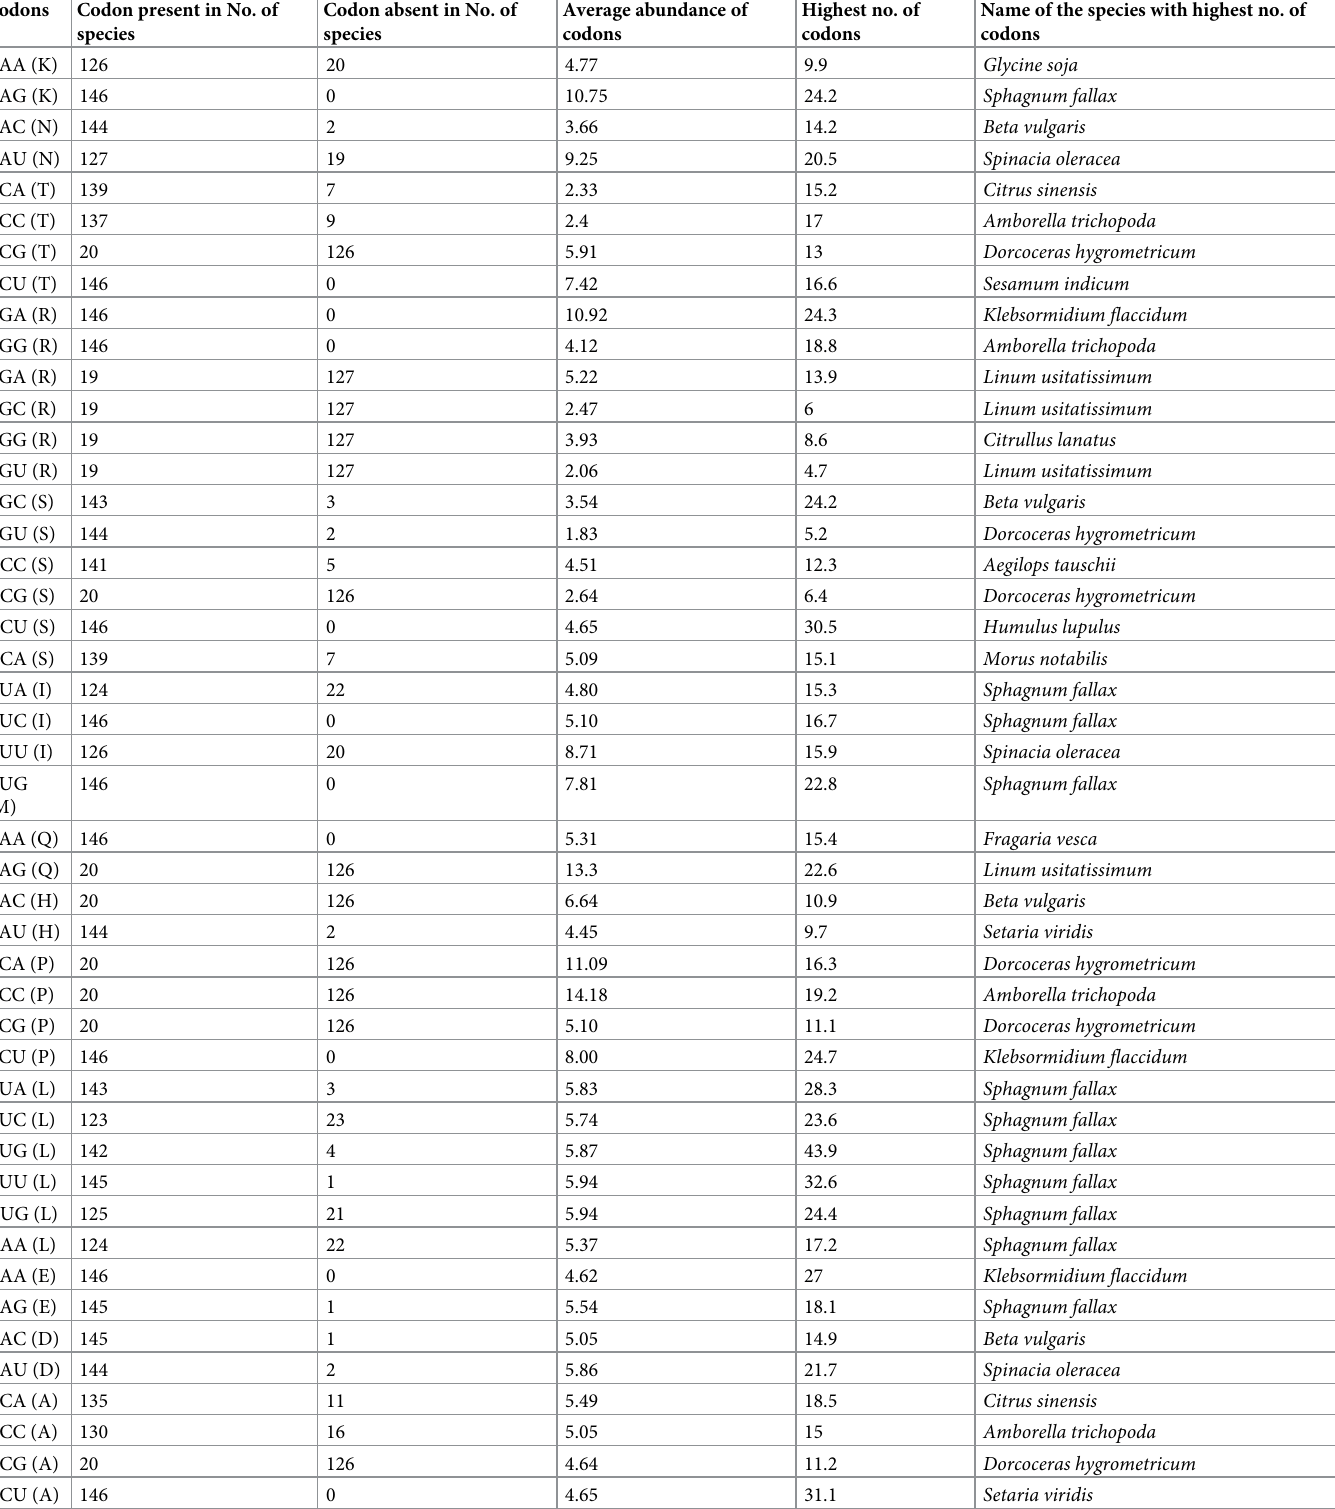
Table 4. Codon usage of NAC TFs in plants. Codons Codon present in No. of